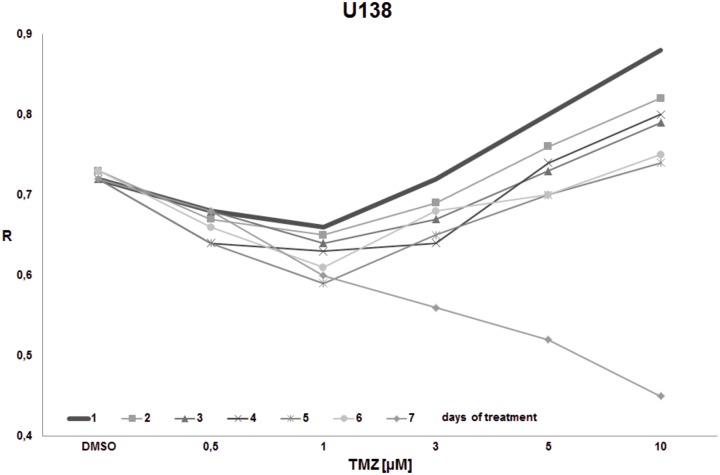
The impact of TMZ exposure period on DNA methylation in U138 cell line.U138 cell culture was treated with the given single dose of TMZ (0.5, 1, 3, 5, 10 μM) and left for 1–7 days. The global DNA methylation was estimated after 1st, 2nd, 3rd, 4th, 5th, and 7th day of incubation. The hypomethylation at prolonged time (7 days) is clearly seen. The hypermethylation is achieved in shorter incubation times in concentrations over 5 μM.